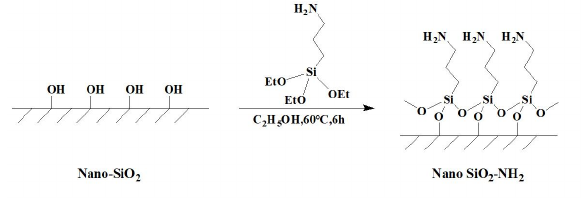
Scheme 1. The reaction scheme of SiO 2 -NH 2